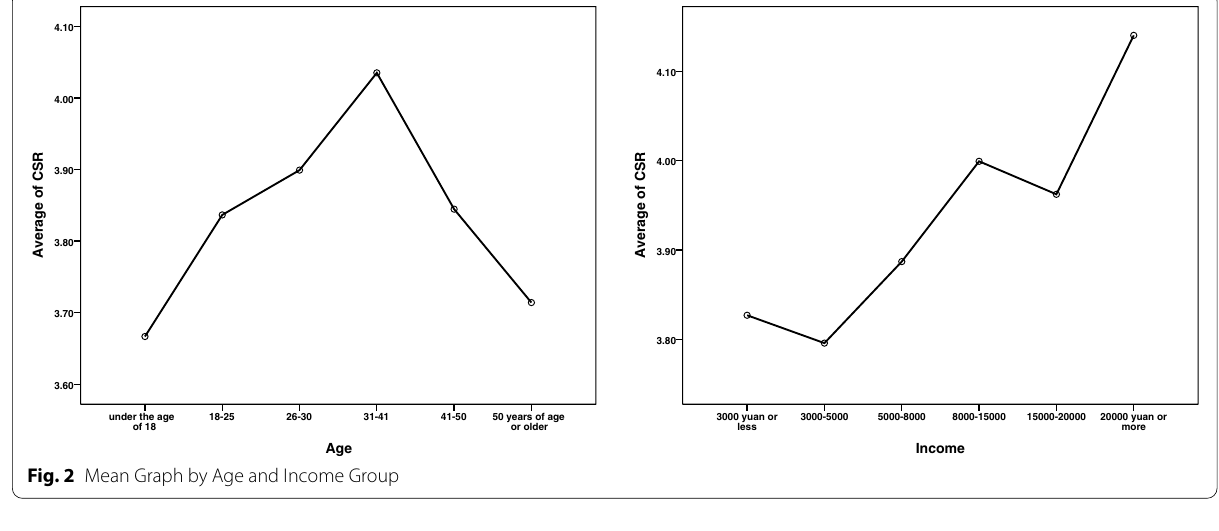
Fig. 2 Mean Graph by Age and Income Group